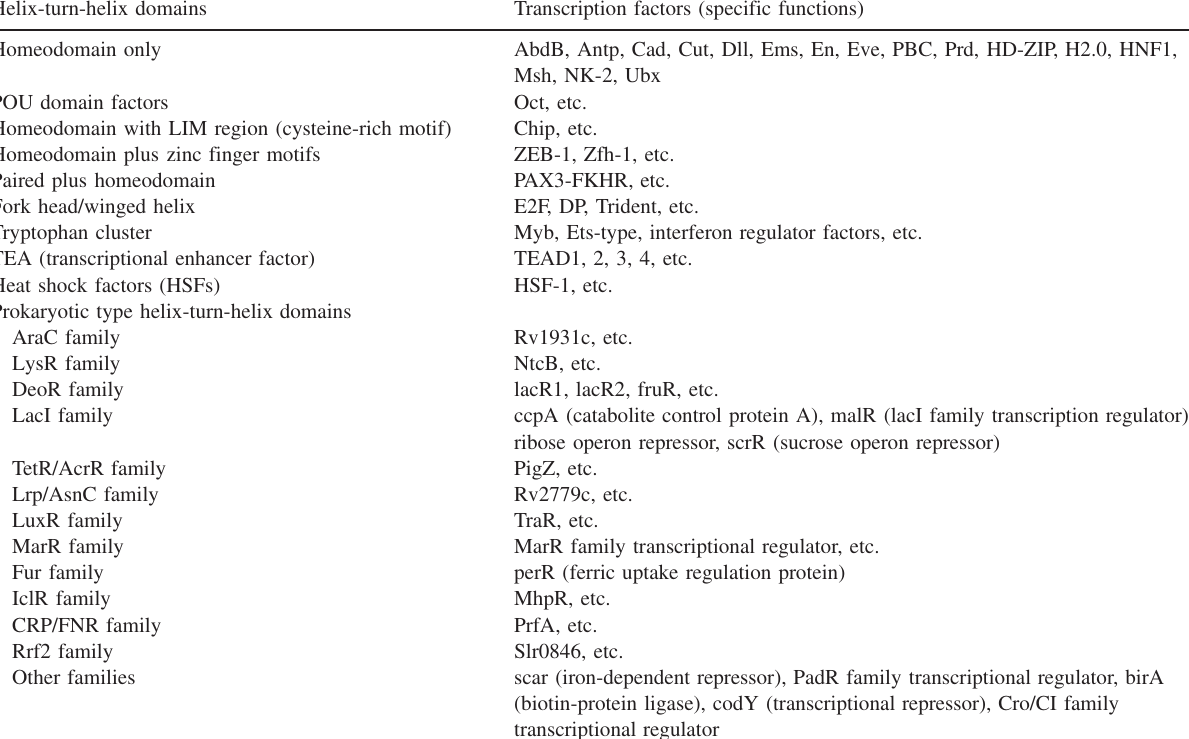
Table 3 Transcription factors with helix-turn-helix domains.